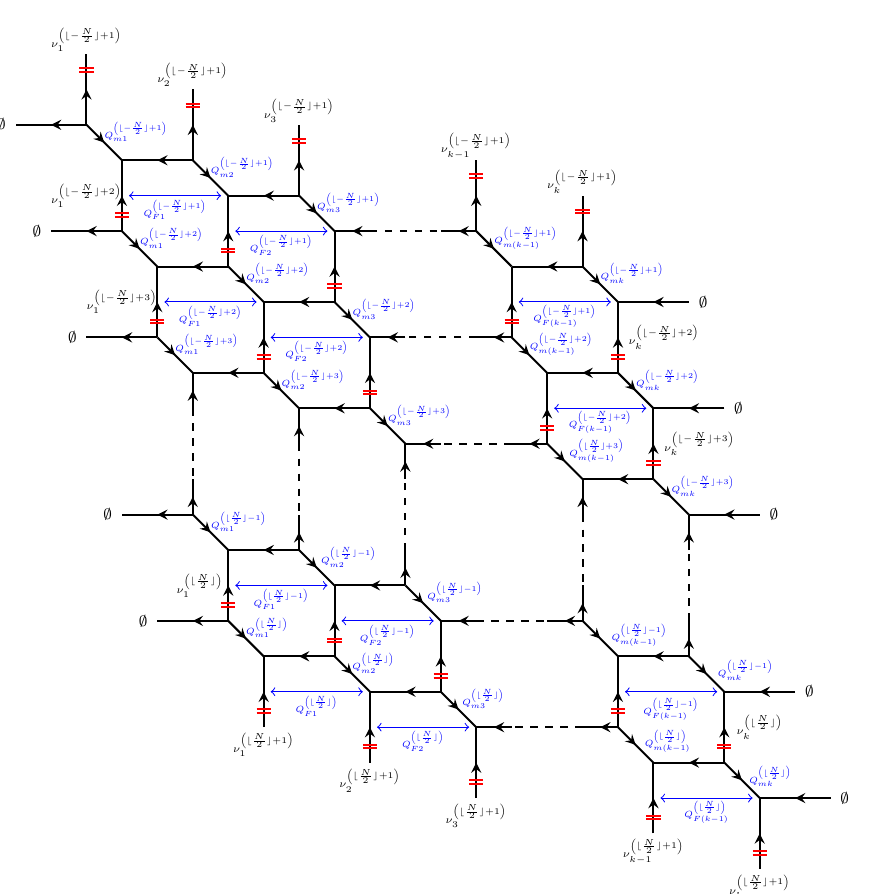
Figure 4 . The dual-toric diagram for the U( k ) N theory. The preferred direction is along the compactified circle and is highlighted in red. There are no non-trivial framing factors. We close the ( ⌊ N ) 2 ⌋ +1 quiver by identifying the partitions ν